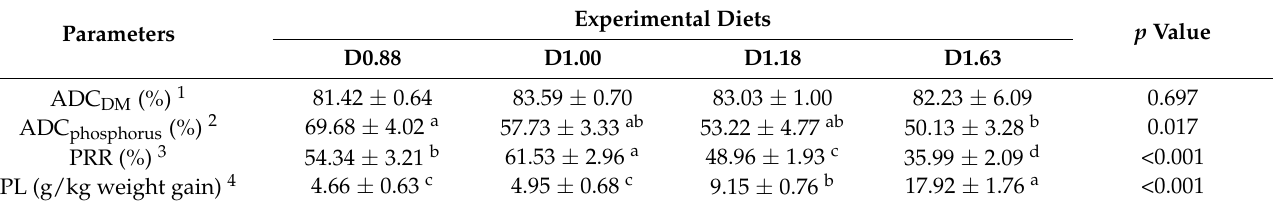
Table 5. Apparent digestibility coefficients and phosphorus utilization in Chinese soft-shelled turtle fed with different phosphorus